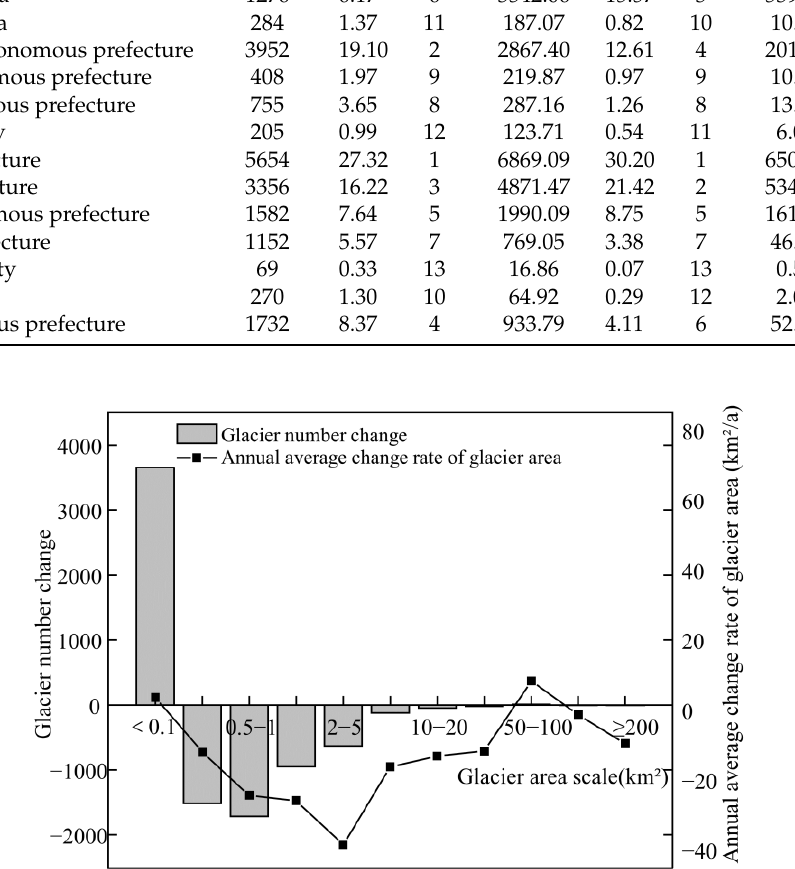
Figure 3. The glacier number change and area retreat rate in Xinjiang from 1960 to 2010.